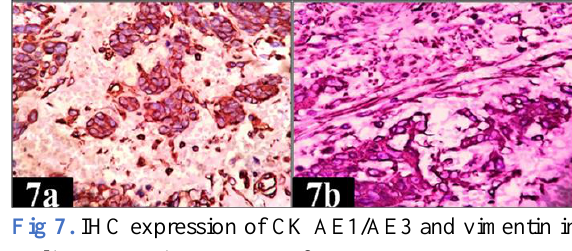
Fig 4. IHC expression of CK AE1/AE3 and vimentin in malignant serous tumor of ovary (a) Membranous staining of CK in few tumor cells (100X) (b) Strong cytoplasmic expression of vimentin (400X)